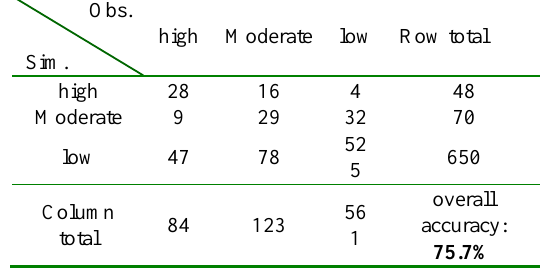
Table 1. Confusion matrix of the simulated vs. observed microhabitat occupancy (unit: pixel) Obs.